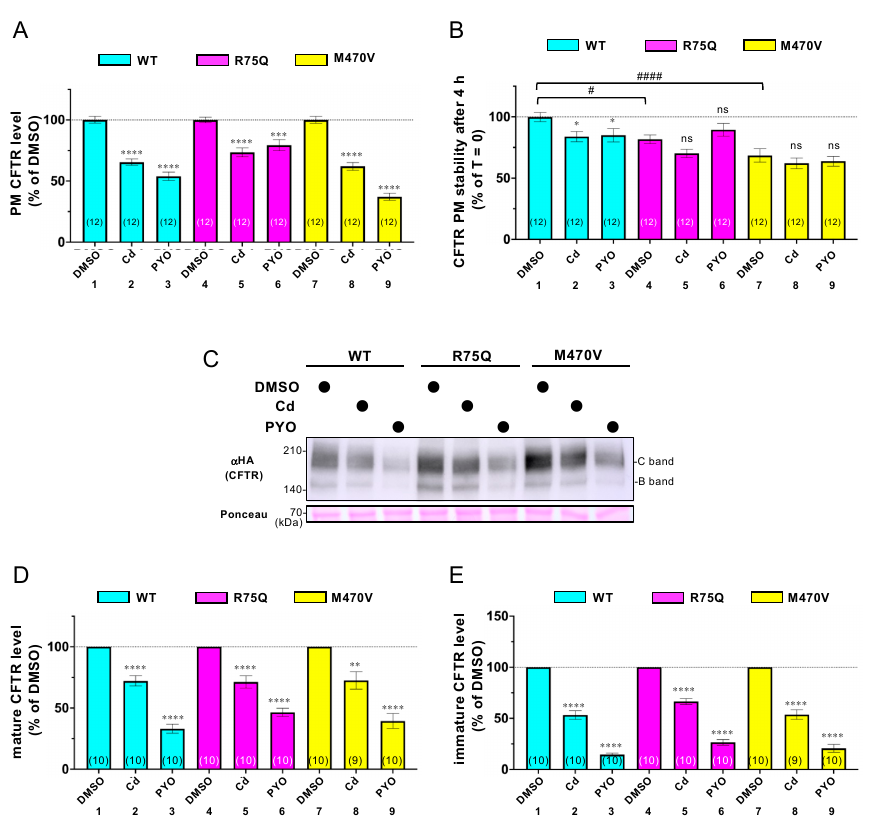
Figure 5. Effect of Cd or PYO on the PM density, stability, and expression of the CFTR variants. CFBE Tet-on cells expressing WT-, R75Q-, or M470V-CFTR were treated with 15 µM Cd or 5 µM PYO for 3 days in the presence of Dox (1 µg/ml). PM density ( A ) and PM stability ( B ) of CFTR were measured by cell surface ELISA using an anti-HA antibody. For the PM stability measurement, Cd or PYO was also treated during 4 hours of incubation at 37 °C following anti-HA antibody binding. ( C – E ) The protein level of CFTR variants was measured by Western blotting. Ponceau staining was used as a loading control. B and C bands indicate immature and mature forms of CFTR, respectively. The mature ( D ) and immature ( E ) forms of CFTR were quantified by densitometry. Data represent mean±SE. The number of data from at least two independent experiments is indicated in parentheses. n.s., not significant; * p < 0.05, ** p < 0.01, *** p < 0.001, **** p < 0.0001 vs. DMSO (one-way ANOVA). # p < 0.05, #### p < 0.0001 vs. WT-CFTR (one-way ANOVA).